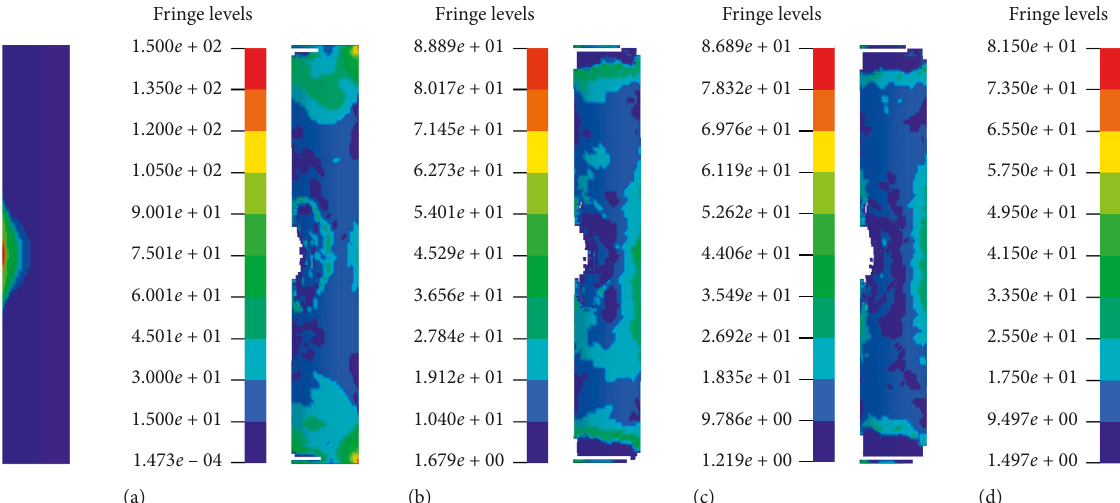
Figure 18: Effective stress contours of concrete at different time periods (left view): (a) t � 0.3ms, (b) t � 1 ms, (c) t � 2 ms, and (d) t � 3